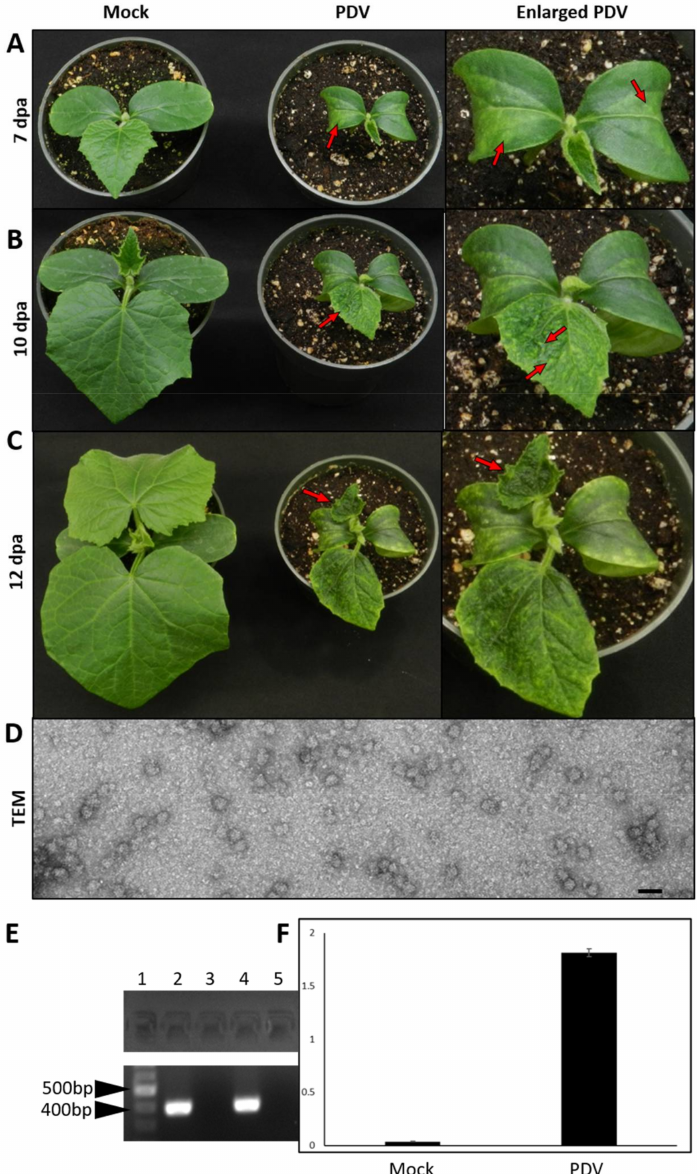
Figure 5. Cucumber serves as a symptomatic host of PDV. To evaluate the use of cucumber as an experimental host for PDV infection, cotyledons of cucumber cv. ‘Wisconsin’ were agroinfiltrated with the full-length cDNA clone of PDV. Left, mock-inoculated; middle, agroinfiltrated with the PDV infectious clone; right, enlarged true leaf of the middle plant. ( A ) At 7 dpa, PDV symptoms are visible on the newly emerging first true leaves as small chlorotic spots and some vein clearing (red arrows). ( B ) At 10 dpa chlorotic leaf spotting is present on the fully expanded first true leaf (red arrows). ( C ) At 12 dpa the second true leaf of PDV infected cucumber exhibits stronger symptoms including chlorosis and leaf deformation (red arrows). ( D ) Isometric shaped virions isolated from PDV infected cucumber leaves were visualized by transmission electron microscopy. ( E ) The presence of PDV in upper non-inoculated leaves of symptomatic cucumber plants was detected by RT-PCR. Lane 1: 1000 bp DNA ladder; 2: non infiltrated first true leaf of PDV infected plant at 12 dpa; 3: distal leaf of mock treated plant at 12 dpa; 4: A sample of foliar tissue known to be infected with PDV served as a positive control; 5: water was used as a negative control to test PCR reactions. ( F ) Relative levels of PDV accumulation in upper, non-infiltrated leaves were determined by DAS-ELISA. Error bars represent the standard deviation of the mean of 9 seedlings for each treatment. This study was performed in 3 independent experiments consisting of 9 cucumber seedlings receiving each treatment during each experiment. For all studies, mock inoculated plants did not generate PDV specific amplicons nor positive results by